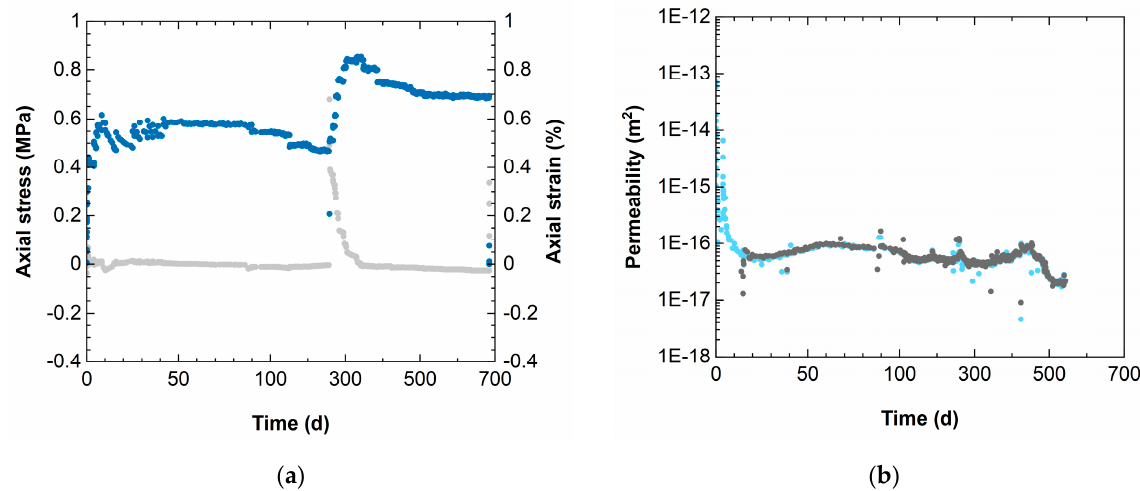
Figure 2. ( a ) Axial strain (grey) and axial stress (blue) and ( b ) inflow (blue) and outflow (grey) permeability cell 9.